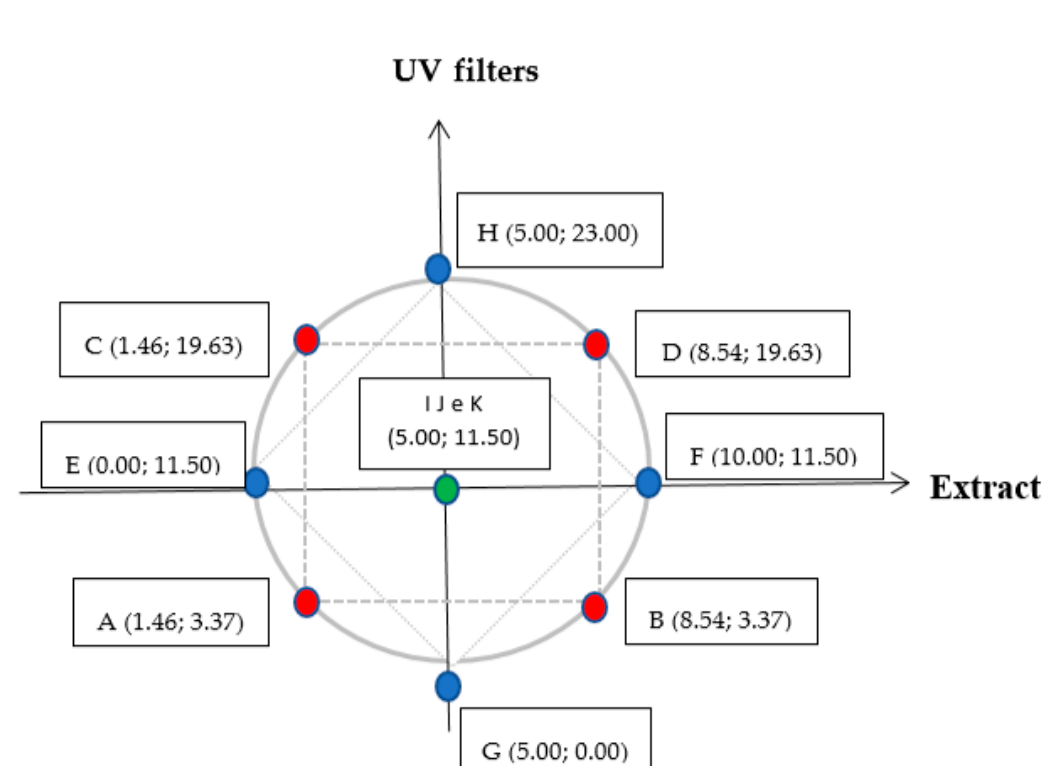
Figure 2. Schematic representation of the DoE using di ff erent concentrations (% w / w ) of grape pomace ( V. vinifera L.) and UV filters. (X, Y)—X is the total concentration of extract in % ( w / w ) and Y is the total UV filter concentration in % ( w / w ). ( A – K ) cosmetic formulations. Extract: dried red grape pomace. UV filters: butylmethoxydibenzoyl methane (UVA), ethylhexyl methoxycinnamate (UVB) and ethylhexyl dimethyl PABA